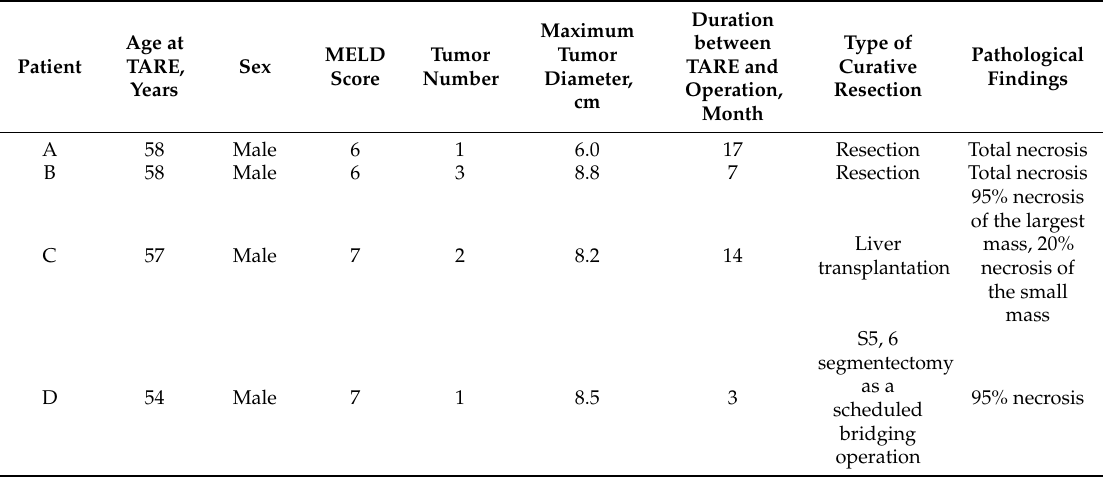
Table 4. Pathological information of patients who achieved complete